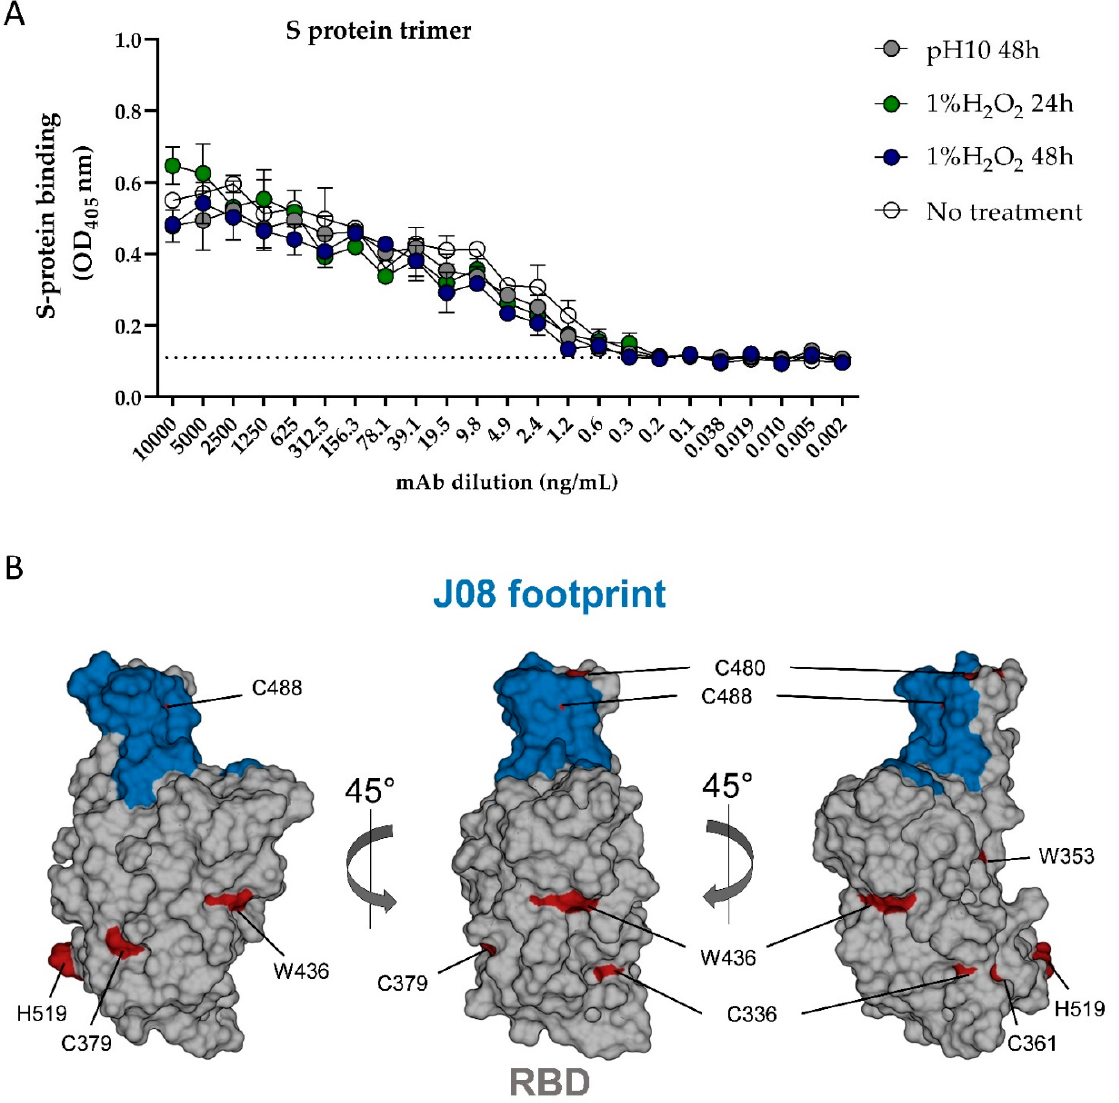
Figure 7. Binding measurements of mAbs batch 20G before and after incubation with 1% of H 2 O 2 and at pH 10 for 24 and 48 h. Threshold of positivity was set as two times the value of the blank (dotted line) ( A ). Representation of the SARS-CoV-2 S protein RBD. J08 footprint is highlighted in blue; cysteines, histidines, and tryptophans are highlighted in red ( B ).